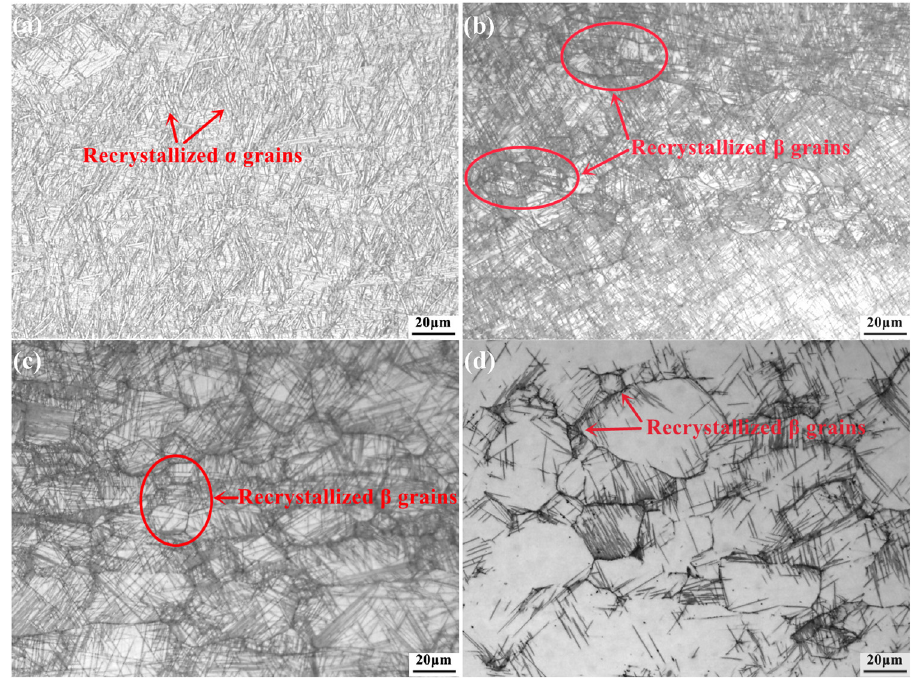
Figure 16: Microstructures after deformation at the same strain rate of 0.1 s − 1 and di ff erent temperatures of ( a ) 940°C; ( b ) 970°C; ( c ) 1,000°C; and ( d )